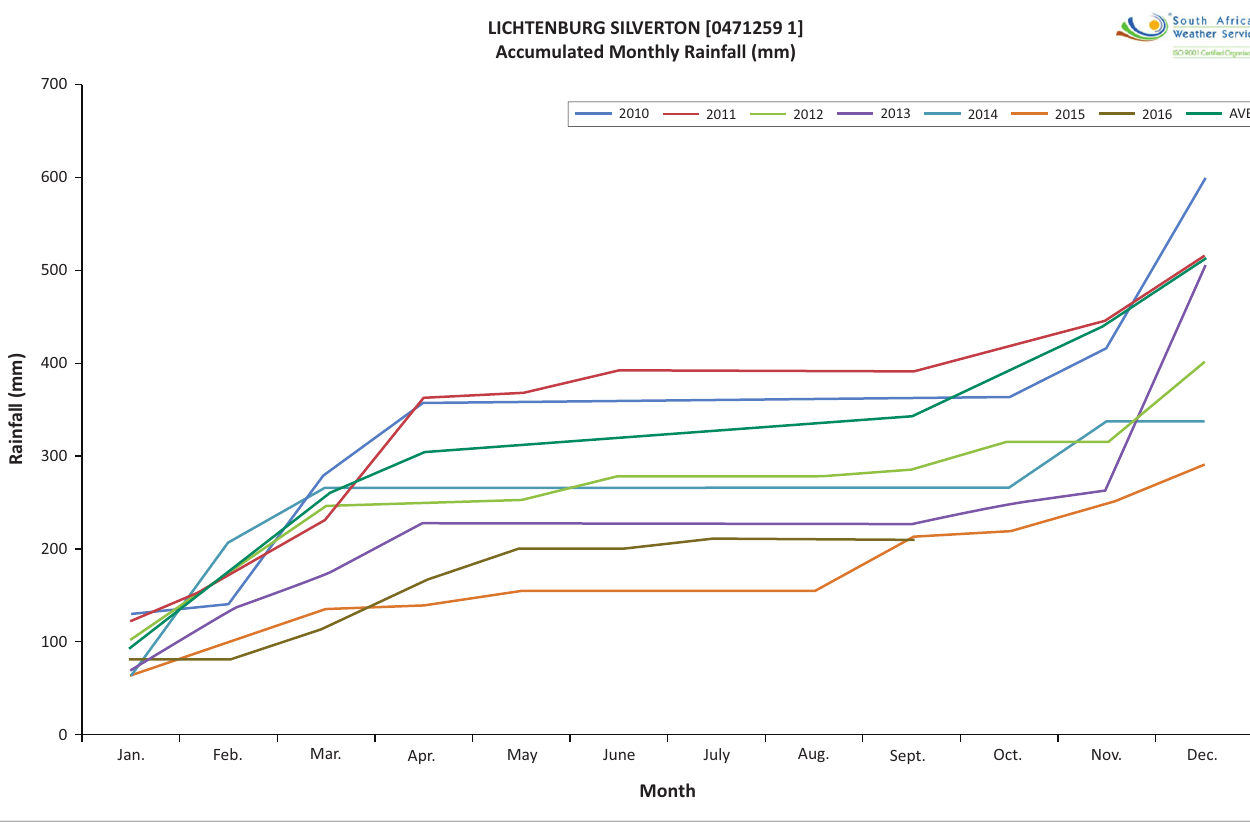
FIGURE 4: Accumulated monthly rainfall: Lichtenburg